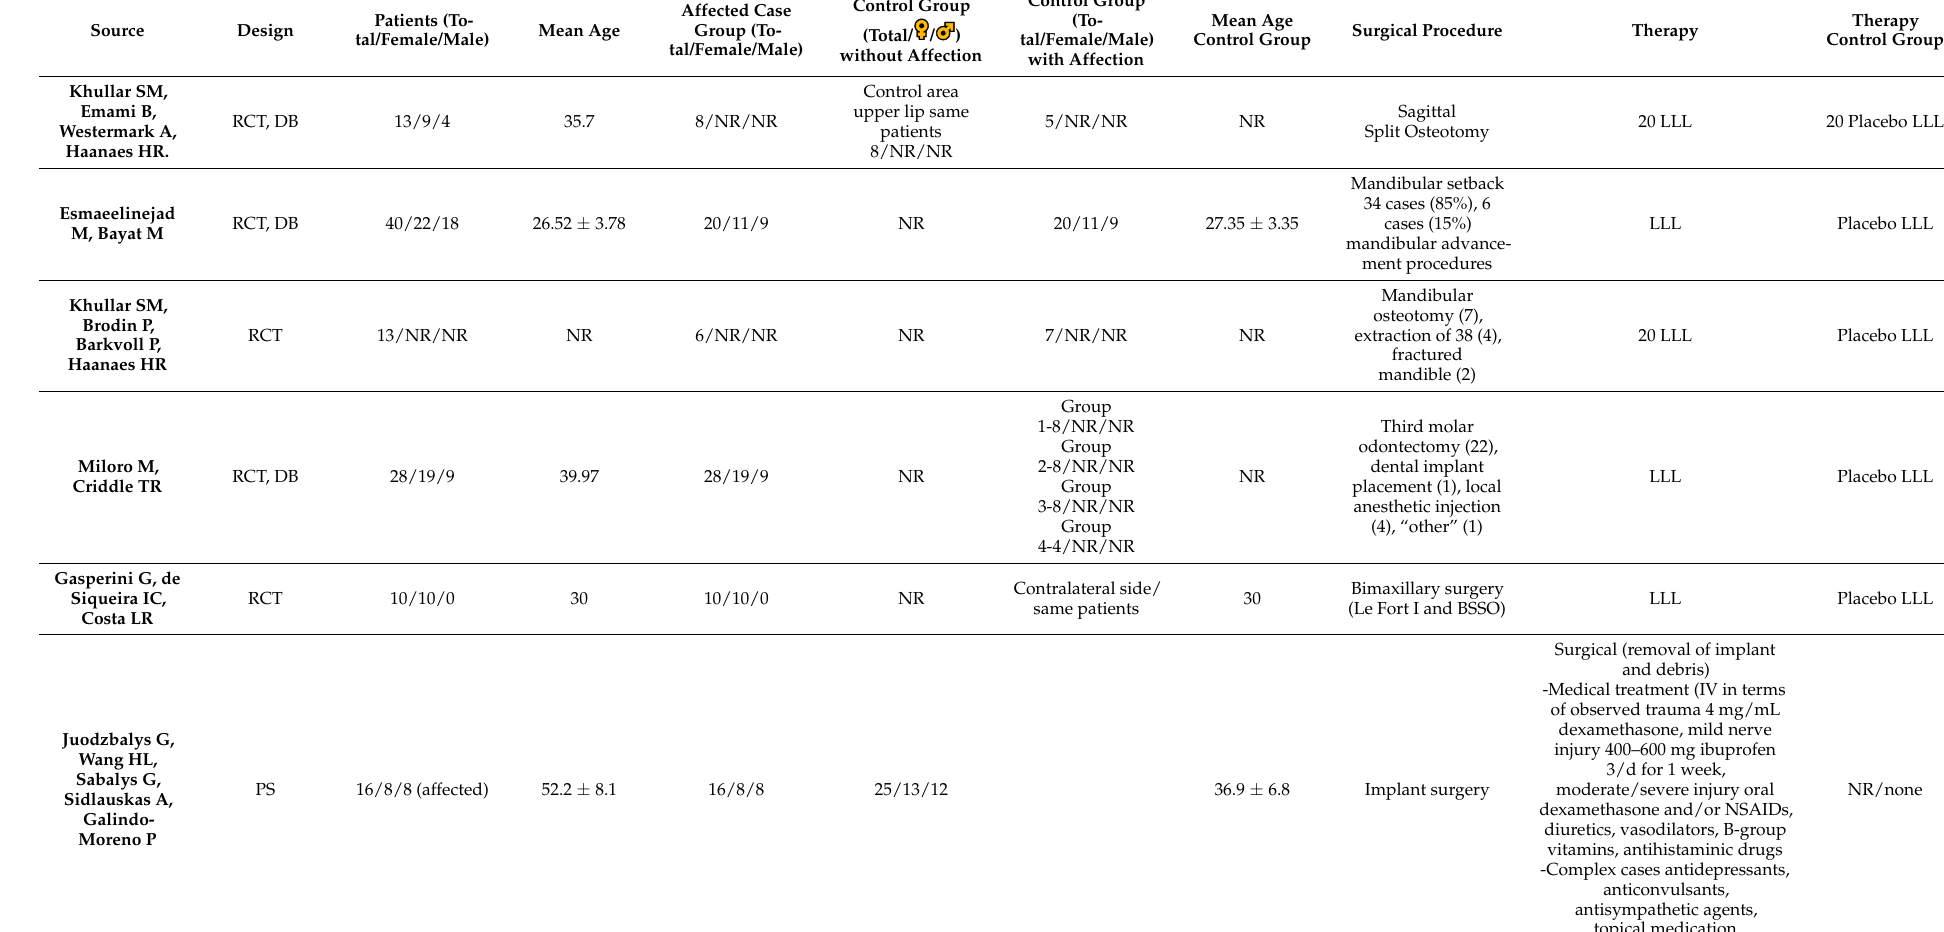
Table 4. Demographic and clinical characteristics.